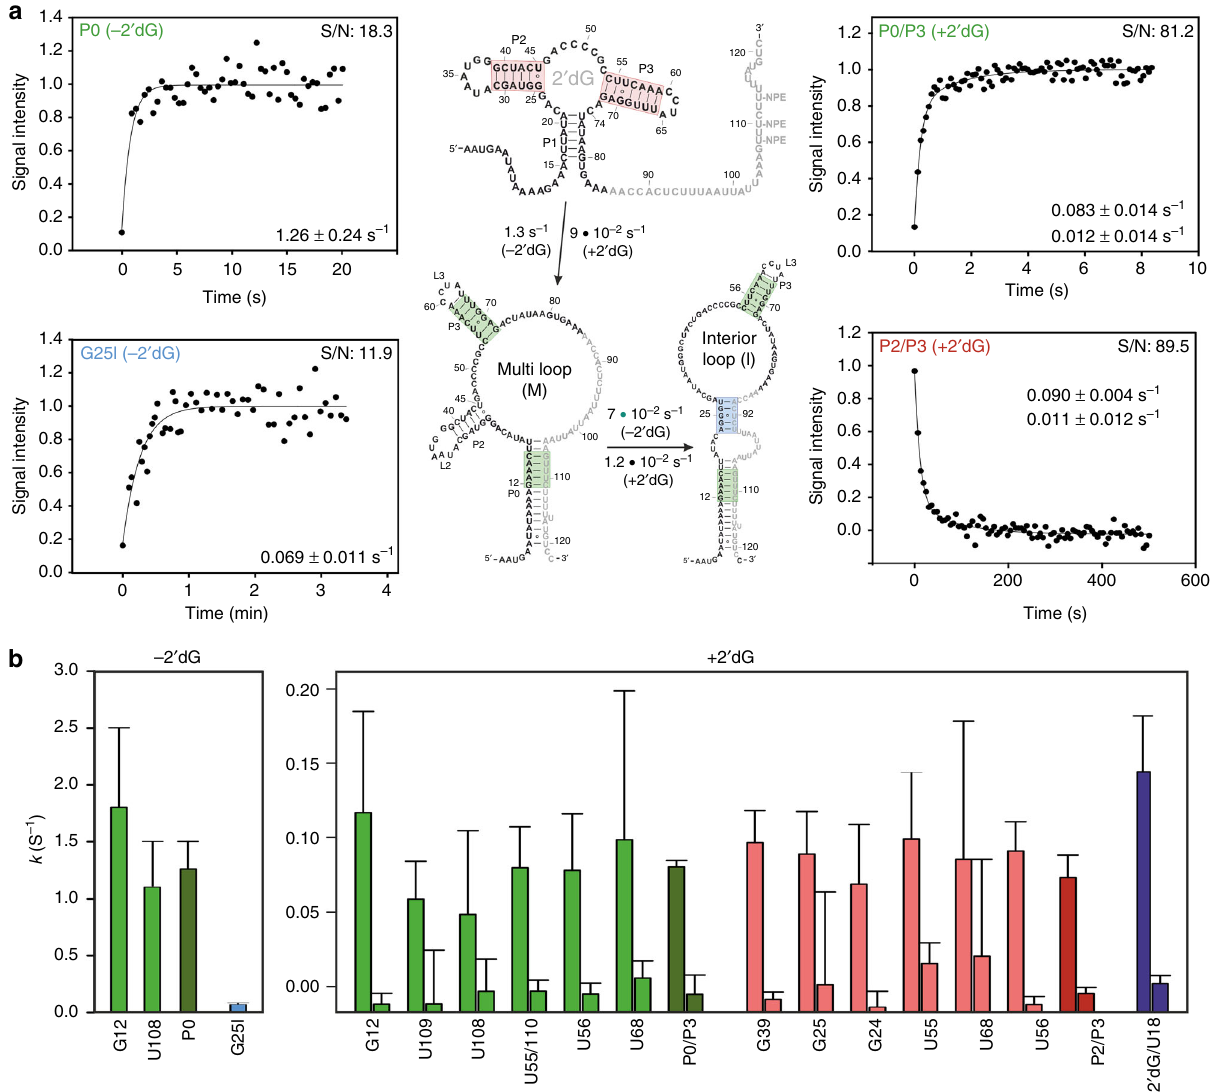
Fig. 3 Kinetic traces for ON state folding. a Averaged kinetic traces for antiterminator P A T(M) formation in presence and absence of ligand (green), kinetic trace for antiterminator P A T(I) formation derived from the imino proton reporter signal G25I (blue), and averaged kinetic trace for aptamer dissociation in the presence of ligand (red). Dissociation and association of helical segments monitored by real-time NMR are color coded accordingly in the secondary structure depiction on the right. b Individual rates derived from transients shown in ( a ) and Supplementary Fig. 3. Green bars indicate rates of P0 and P3 formation in P A T(I) and P A T(M) conformations, with the dark green bar corresponding to averaged rates for complete helix formation. The blue bar shows kinetic rates for P A T(I) formation only. Red bars correspond to helix P2 and P3 dissociation in the ligand-bound state and dark red to the averaged dissociation of helix P2 and P3. The purple bar corresponds to cooperative dissociation of both the ligand 2 ′ dG and U18 (P1). Errors correspond to the s.d. of the fi t. S/N values shown correspond to the S/N ratio of the latest data